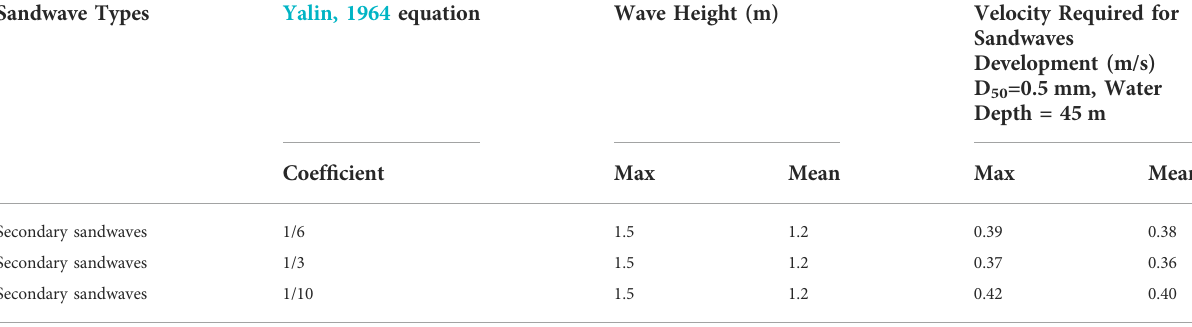
TABLE 4 Different coef fi cient parameters of the Yalin, 1964 equation to estimated fl ow velocity required for the development of the secondary sandwaves. Sandwave